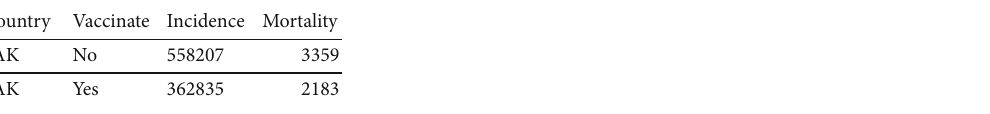
Figure 5: Algorithm visualization. An example of the visualization produced from the online tool. If the user is interested in implementing a candidate maternal RSV vaccine in Pakistan, they would select this country from the dropdown menu. If the distribution to pregnant mothers was estimated at 50% and the e ffi cacy was estimated at 70%, over 195,000 cases of RSV and over 1,100 RSV-ALRI mortalities could have been avoided in Pakistan alone. The algorithm also reports that if this program were implemented in every USAID MCHN priority country, over 2 million cases of RSV and nearly 15,000 infant mortalities could be avoided